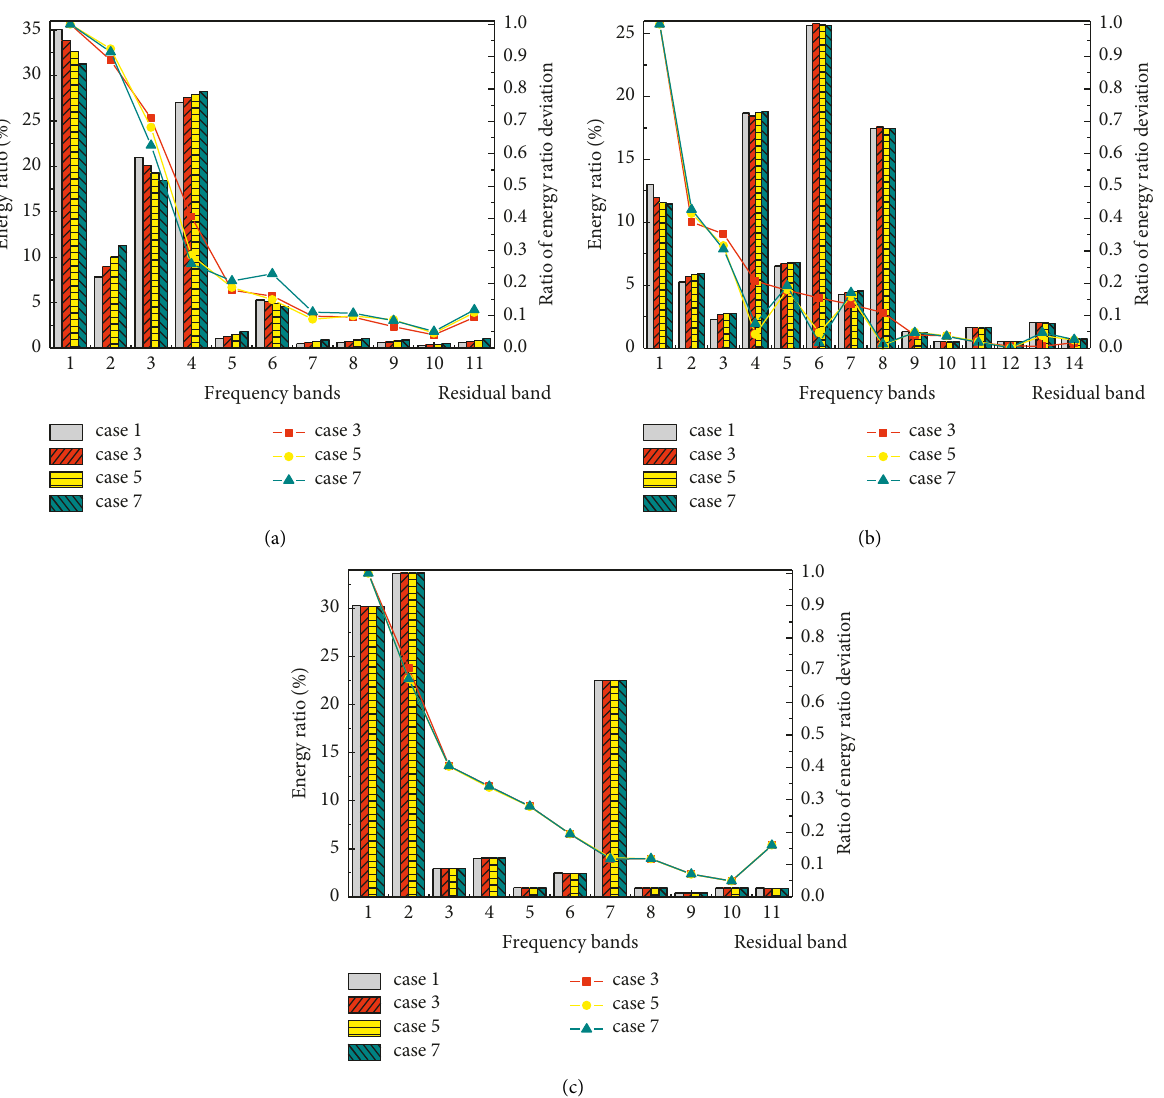
Figure 8: The further updated Wavelet Packet frequency bands energy ratio spectrum of different measurement points (the second time test at excitation point II). (a) Point 4. (b) Point 5. (c) Point